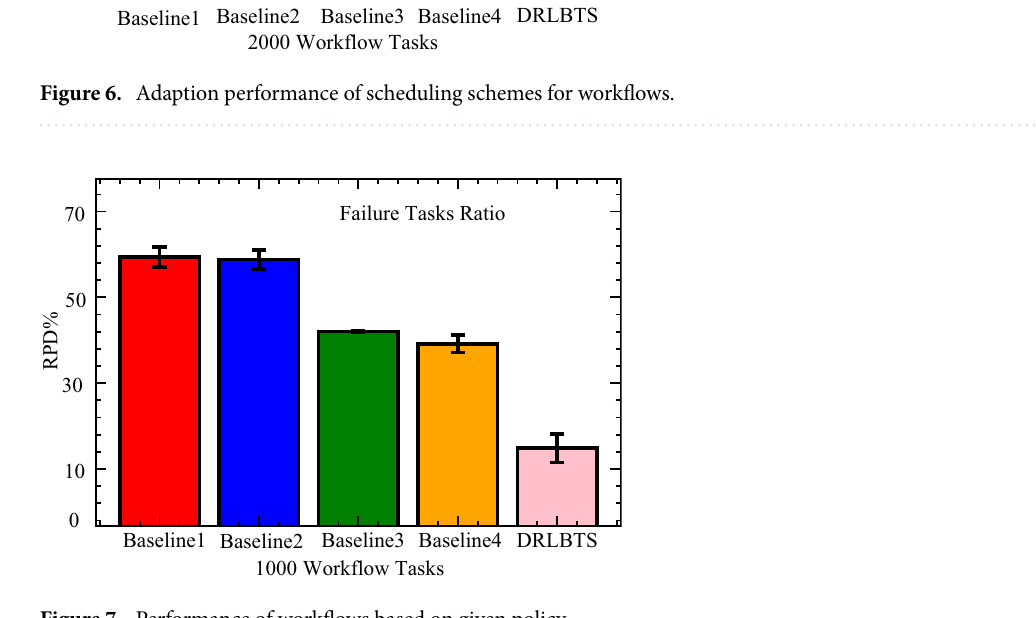
Figure 7. Performance of workflows based on given